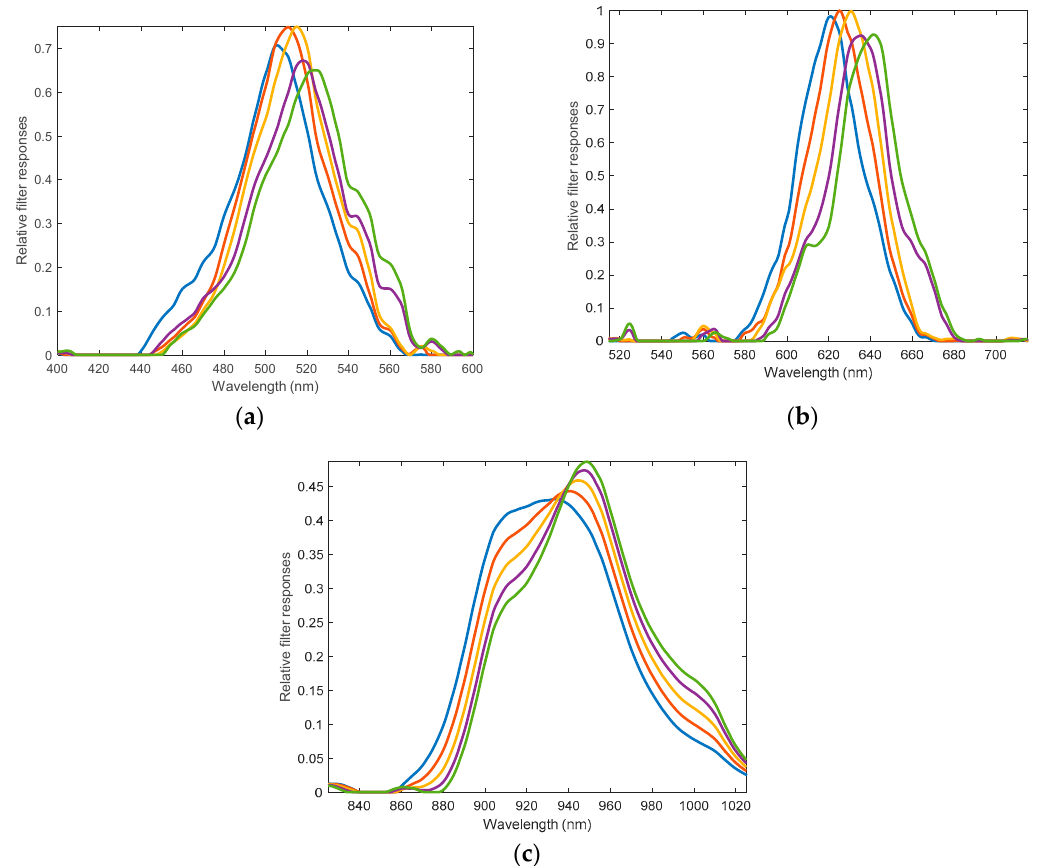
Figure 12. Filter responses of the 15 filters fabricated in the MW-PPG sensors developed: ( a ) in blue region; ( b ) in green region, and ( c ) in IR region.